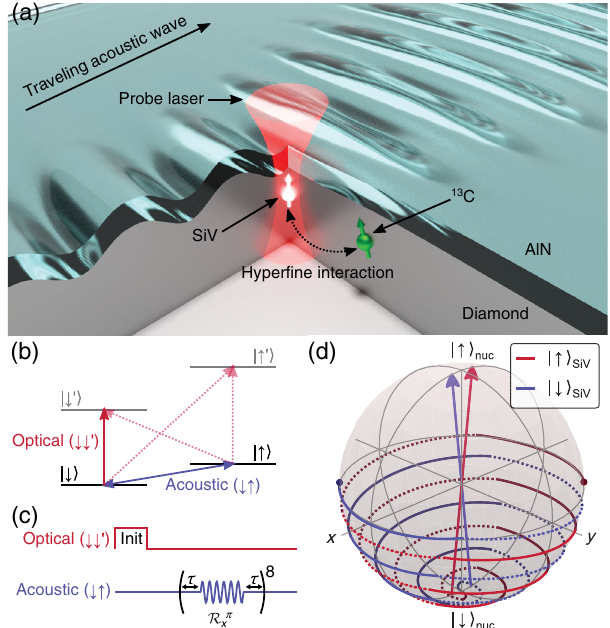
FIG. 1. Principle behind mechanical coupling to nuclear spins. (a) Schematic of the system. Surface acoustic waves (SAWs) generated in the AlN layer, and extending into diamond, are used to control the 13 C nuclear spin via its hyperfine coupling to the silicon vacancy (SiV) electron spin, which can be initialized and read out optically. (b) Simplified electronic structure of the SiV in the presence of an external magnetic field. The red arrows (both dashed and solid) indicate optical transitions around 737 nm. The solid red arrow corresponds to the transition ð ↓↓ 0 Þ used for optical pumping to initialize the SiV state in j ↑ i . The blue arrow corresponds to the 3.42-GHz spin-flipping transition ↓↑ that can be driven acoustically. (c) Schematic of a sequence that induces conditional precession of the nuclear spin. The optical part corresponds to the optical initialization of the SiV spin into j ↑ i . The SiV spin can be initialized in j ↓ i by exciting the ↑↑ 0 transition. The acoustic part corresponds to a series of eight, periodically timed, acoustic π pulses around the X axis of the Bloch sphere ( R π x ). (d) Simulation of the evolution of the nuclear spin on the Bloch sphere for the sequence described in diagram (c). The red (blue) arrow corresponds to the nuclear spin precession axis when the SiV is in j ↑ i ( j ↓ i ). The nuclear spin starts in j ↓ i and follows the red (blue) trajectory when the SiV nuc is initially in j ↑ i ( j ↓ i ). Spin flips of the SiV are indicated by transitions between solid and dashed trajectories. The red (blue) dot indicates the final state of the nuclear spin for the SiV initially in state j ↑ i ( j ↓ i ). The hyperfine coupling parameters used are f A ¼ 0 . 11 MHz ; A ⊥ ¼ 0 . 33 MHz g , and the interpulse time is k τ ¼ 0 . 169 μ